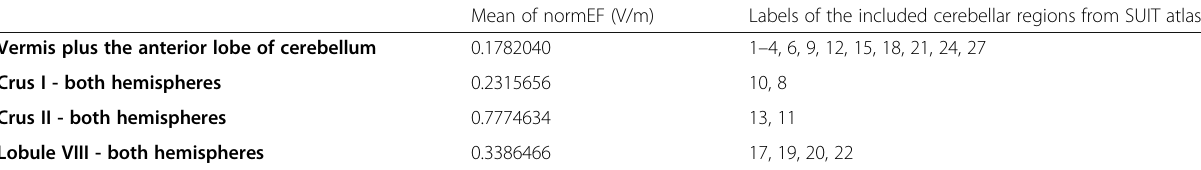
Table 1 Mean values of the electric field (normEF) in four different regions of the cerebellum based on the SUIT atlas [9] calculated using SimNIBSc [32] Mean of normEF (V/m) Labels of the included cerebellar regions from SUIT atlas Vermis plus the anterior lobe of cerebellum